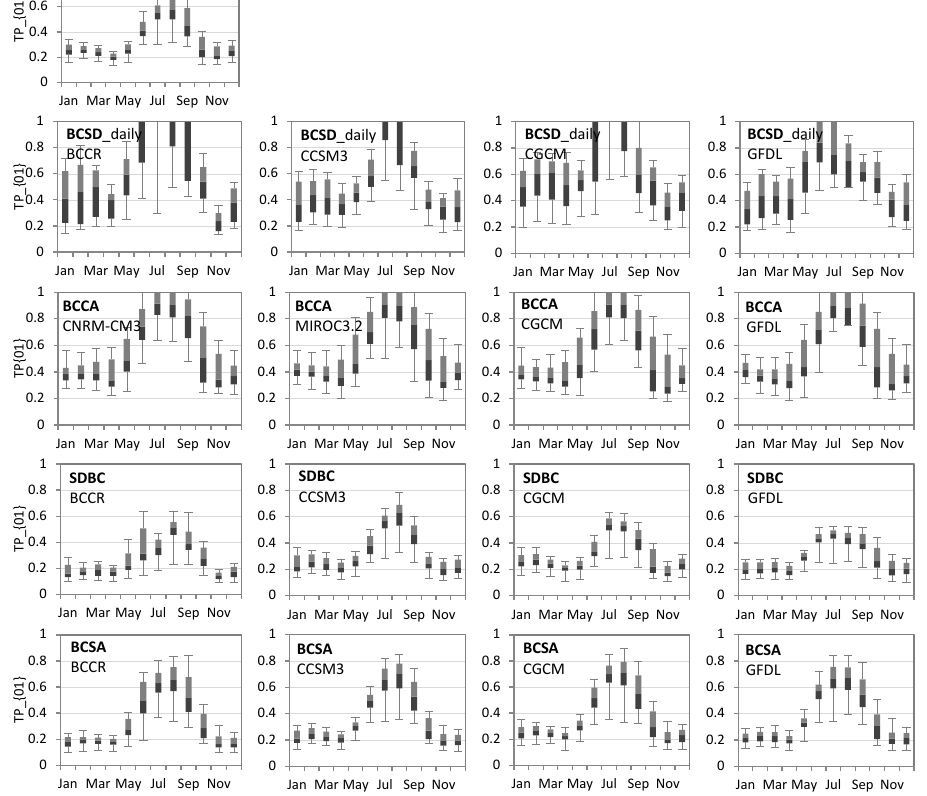
Fig. 12. Comparisons of monthly first-order dry to wet transition probability (TP_{01}) for observations (first row), BCSD_daily results (second row), BCCA results (third row), SDBC (fourth row), and BCSA results (fifth row) for 4 GCM products over all grids in the study area. Box plot presents minimum, 10th percentile, median, 90th percentile, and maximum over the